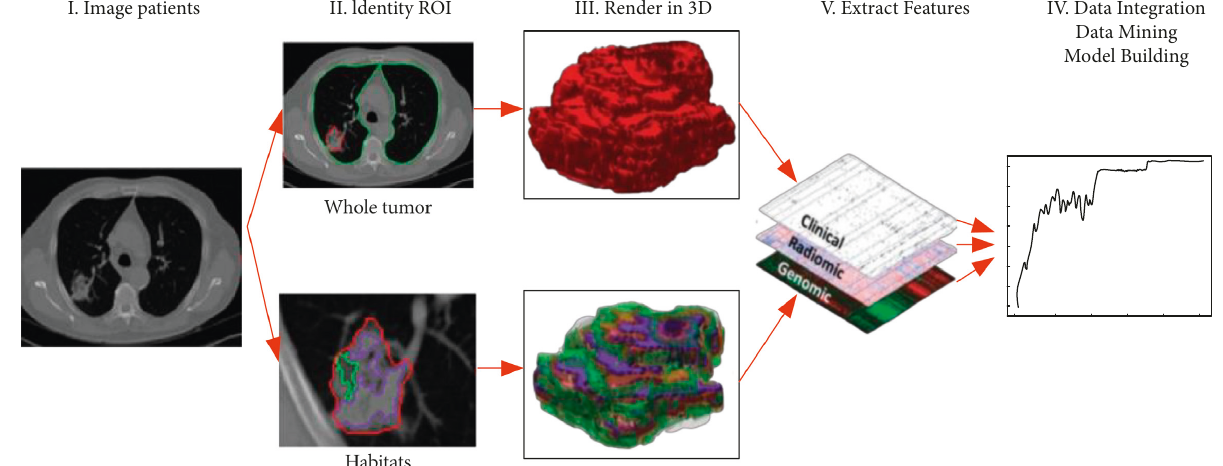
Figure 1: The application framework of radiomics methods in medical imaging.